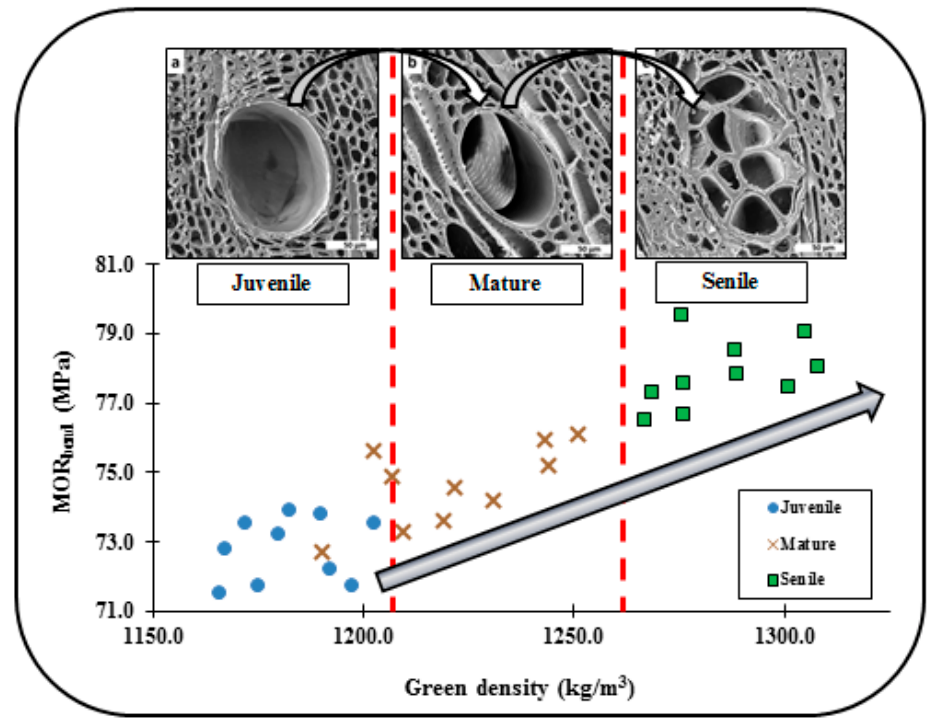
Figure 12. The progressive increment in the thickness of cell-walls for vessel elements embedded in parenchyma cells from juvenile to senile eucalyptus tissue-microstructure likely influences on the linear increase in density and bending strength as the wood-tissue ages. It was found in this study that this is a common phenomenon for both studied species in terms of density, compressive and bending strength and stiffness. Yet, the cell-wall thickness augmentation is of greater magnitude for the eucalyptus species.